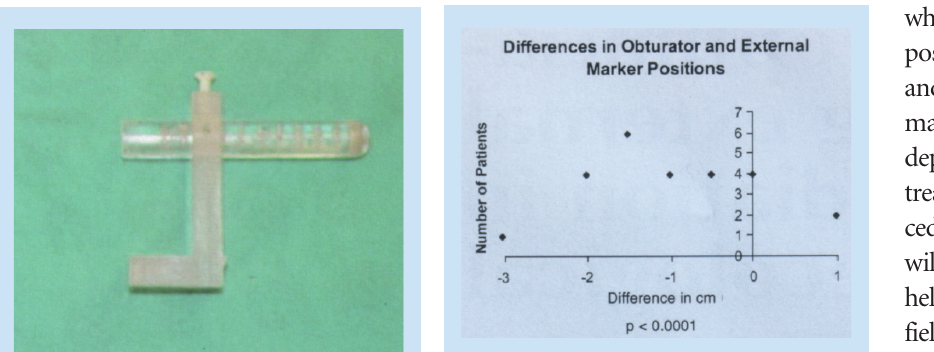
Fig. 3. Differences in obturator and external mark- er